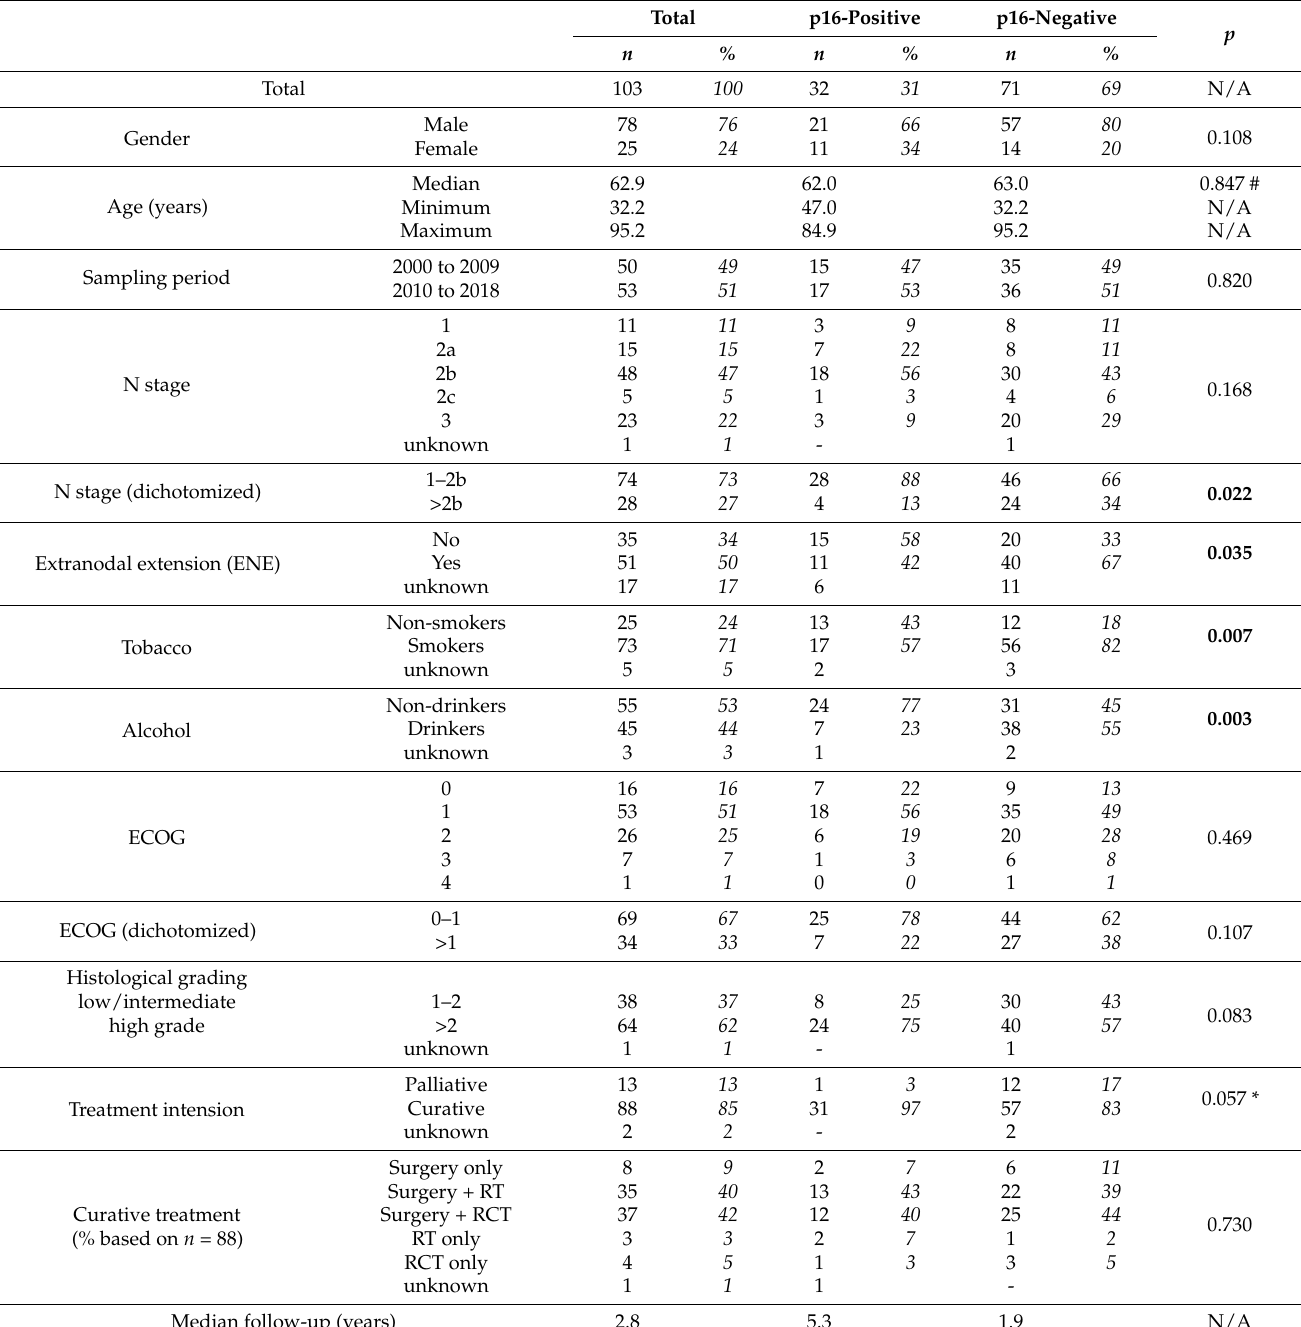
Table 1. Descriptive analysis of CUP HNSCC according to p16